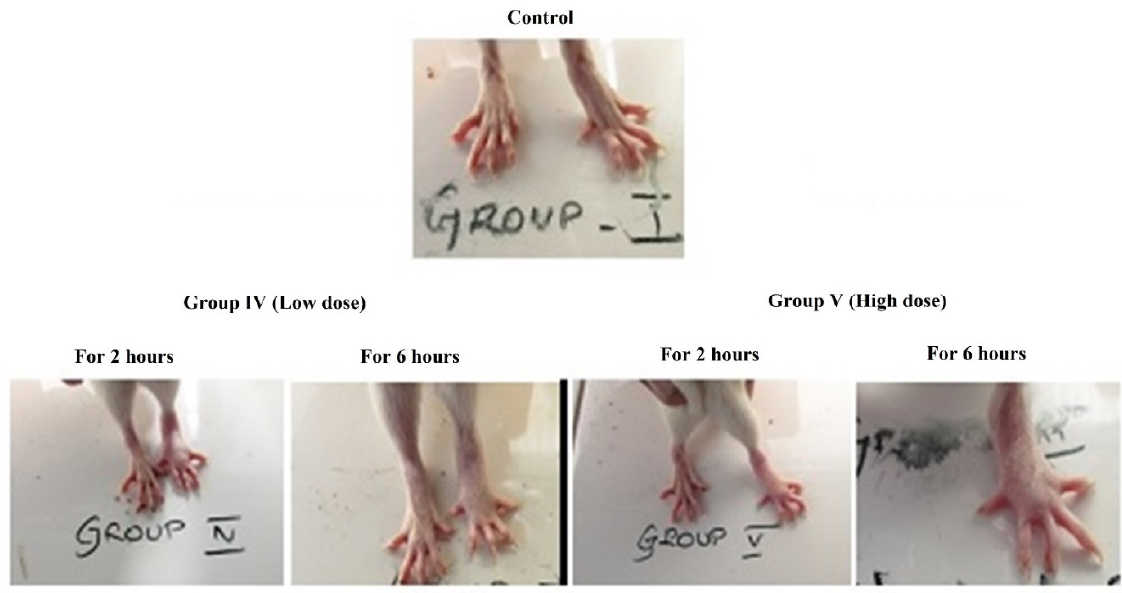
Figure 4. Anti-inflammatory analysis of dimer of epicatechin in Wistar rats. The data presented as mean value ± SE ( n = 3). The model was significant with p < 0.05.